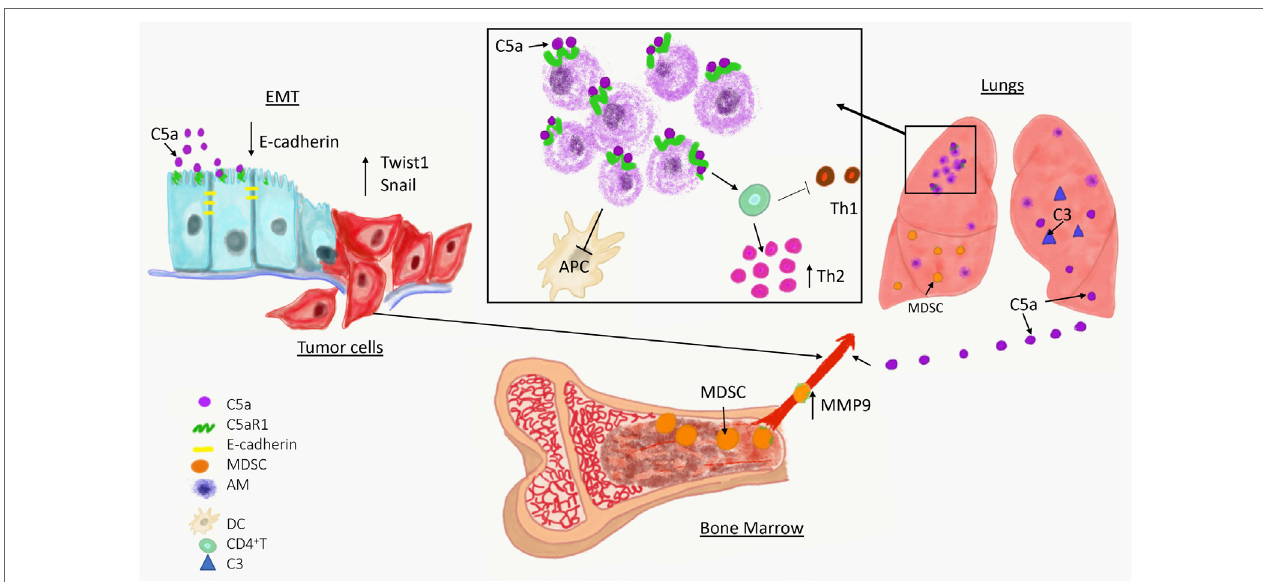
FiGURe 1 | Overview of a role of complement in cancer metastasis. The C5a/C5aR1 axis contributes to the initial step of the invasion-metastasis cascade epithelial- to-mesenchymal transition, which is essential for tumor cell motility, invasion of extracellular matrix blood vessels. C5aR1 signaling contributes to the formation of the premetastatic niche by recruiting immunosuppressive myeloid-derived suppressor cell from bone marrow to the lungs and by regulating self-renewal of alveolar macrophages that impair antitumor immunity via reducing antigen-presenting capacity of dendritic cells (APC) and polarizing T cell response toward Th2